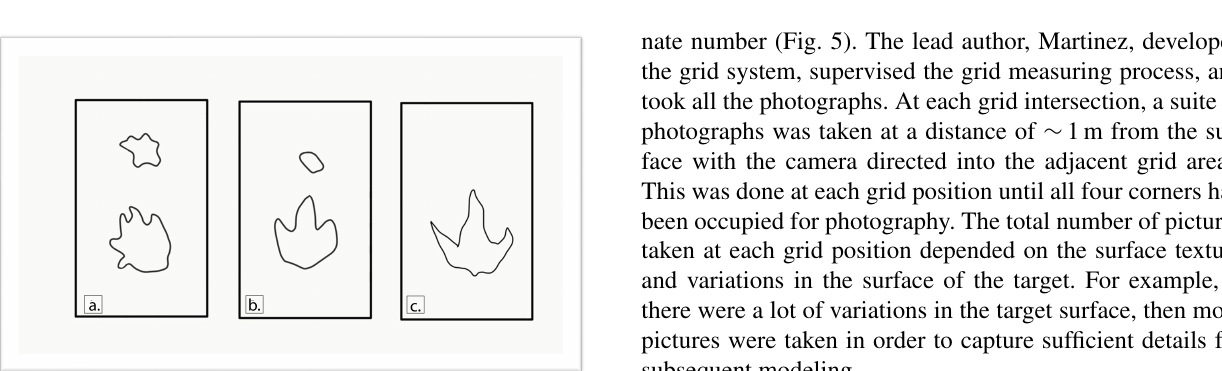
Figure 1. Map of the region modified from ©Google Earth (2021). The red box in the image shows the study area in Cristo Rey, New Mexico.